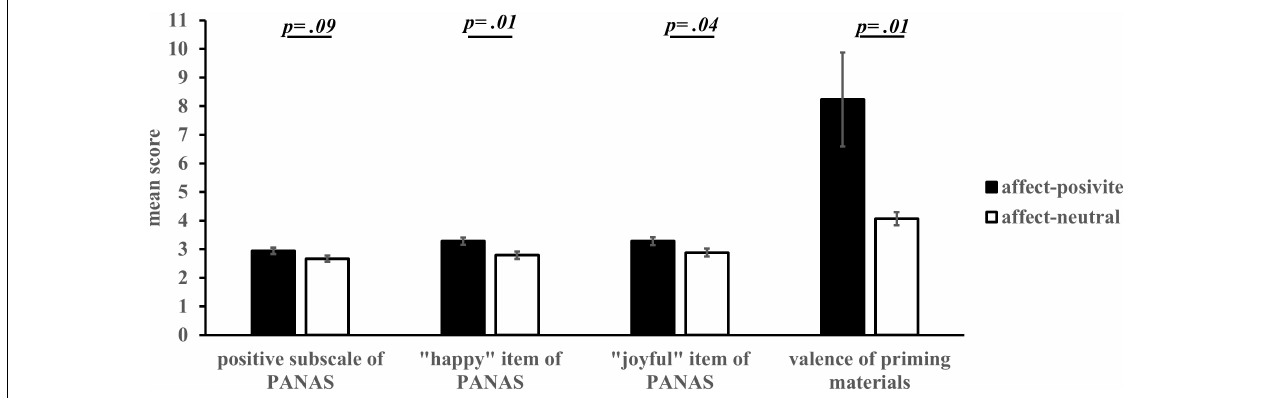
FIGURE 6 | Scores of positive subscale of PANAS and the evaluation of priming materials in different affect groups (M ± SE) .